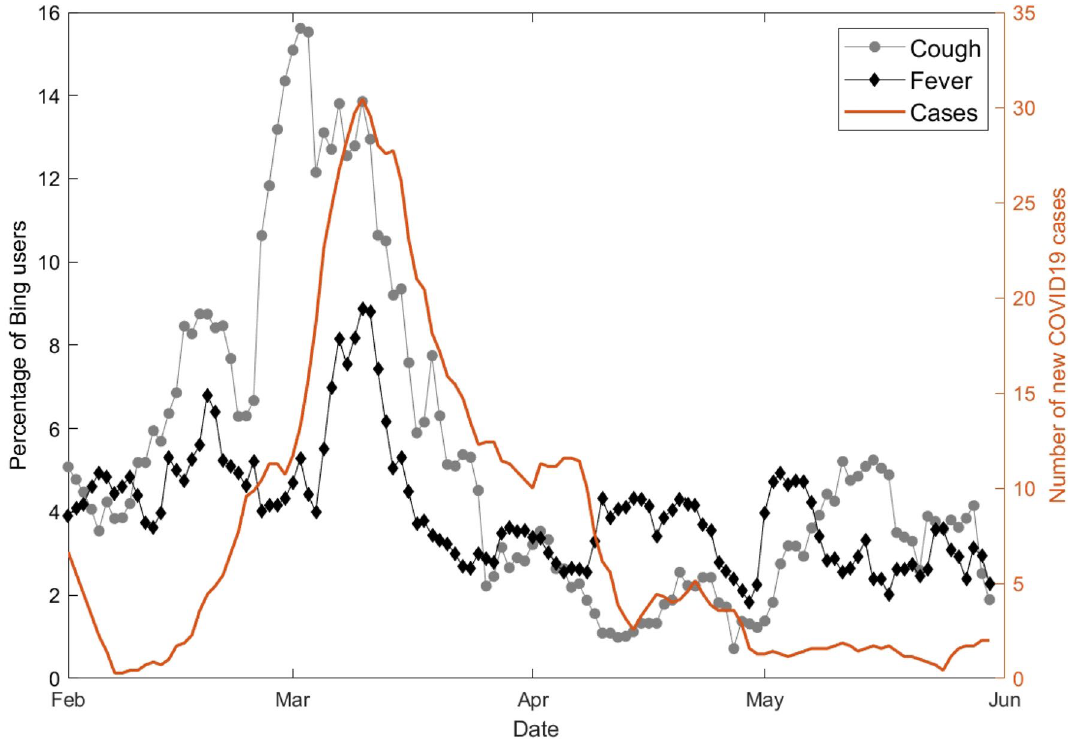
Figure 1. Number of COVID-19 cases (brown) and percentage of Bing users who queried for “cough” in a sample UTLA (gray circles) and for “fever” (black deltoids). Curves are smoothed using a moving average filter of length